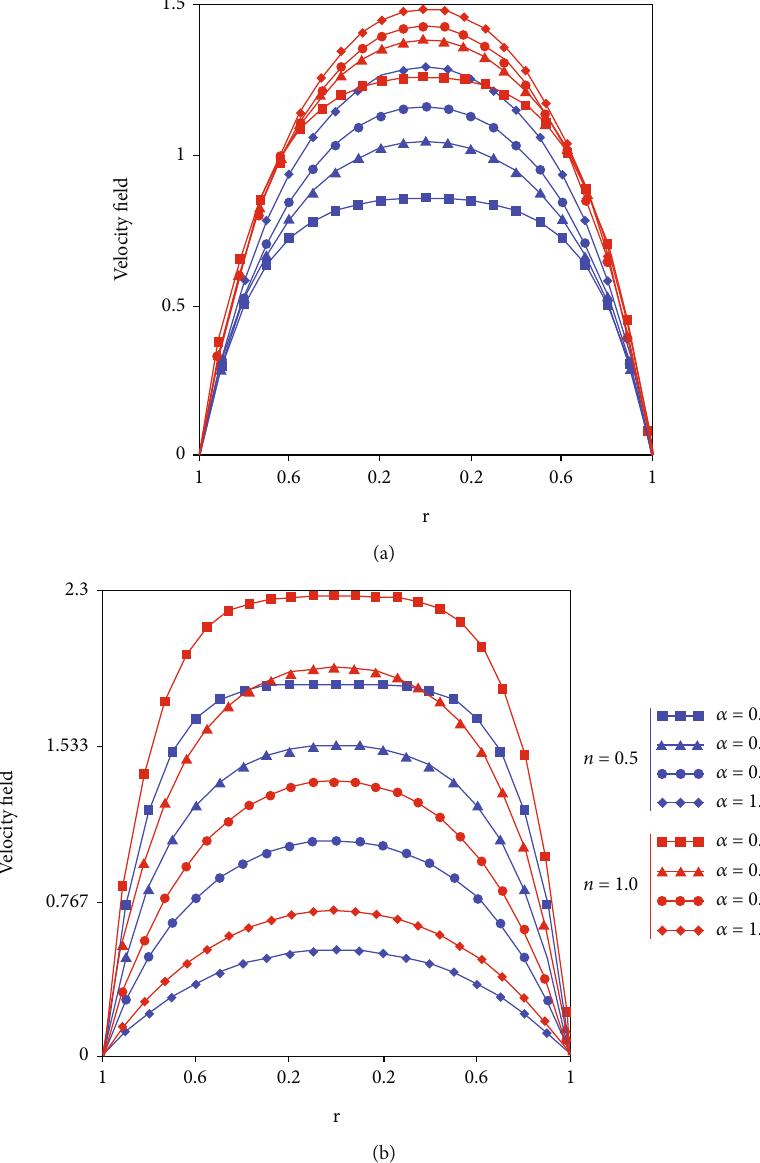
Figure 6: Pro fi les of dimensionless velocity for α versus r at Re = 2 : 5, Ha = 0 : 5, K = 1, n = 0 : 5, 1, for small and large values of time t